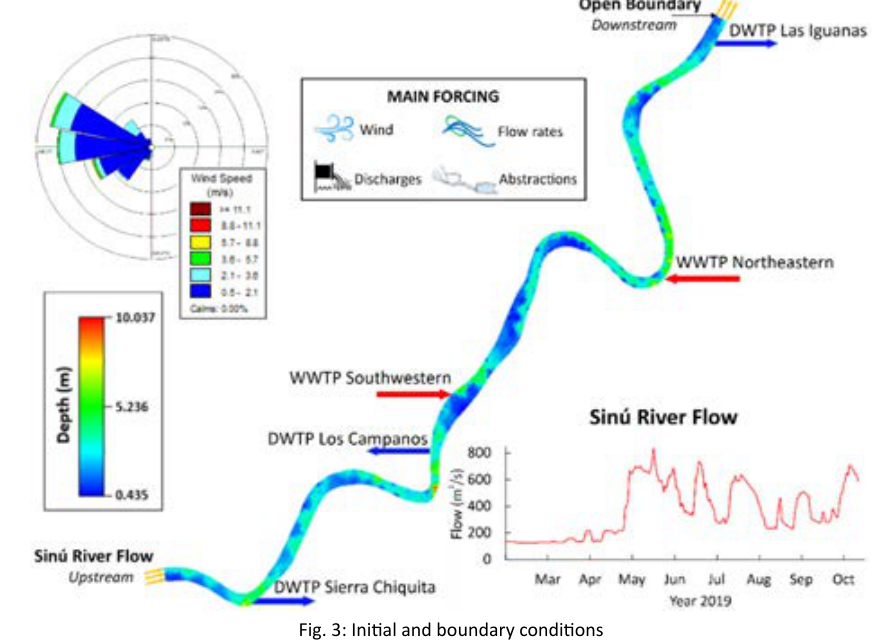
Fig. 3: Initial and boundary conditions Table 1: WWTP parameters concentrations for water quality simulation